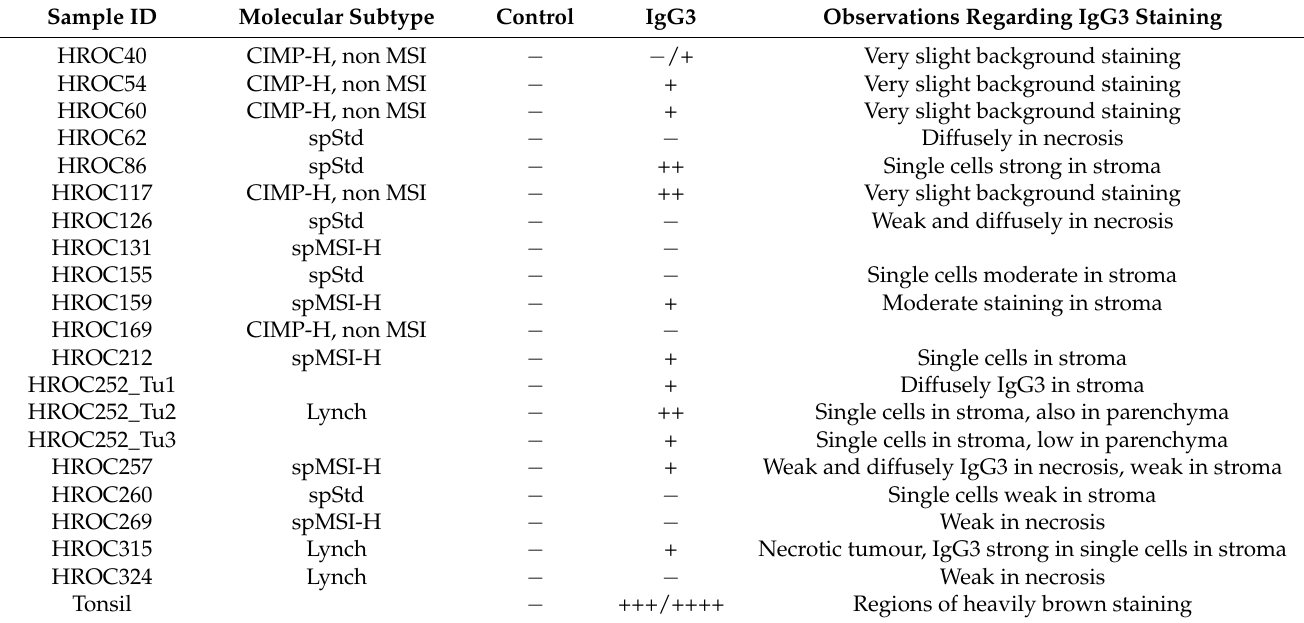
Table 4. IgG3 expression in CRC samples.